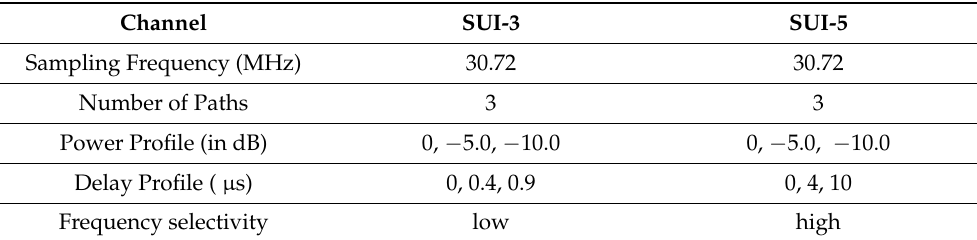
Table 3. Profiles of SUI-3 and SUI-5 channel